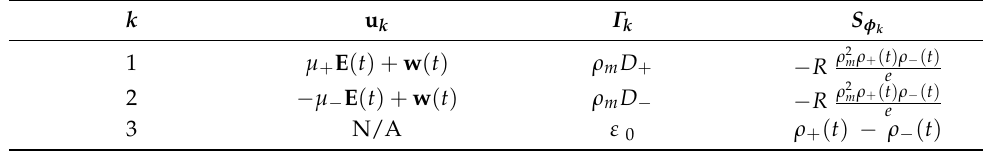
Table 2. Definition of ion flow field variables to Equation